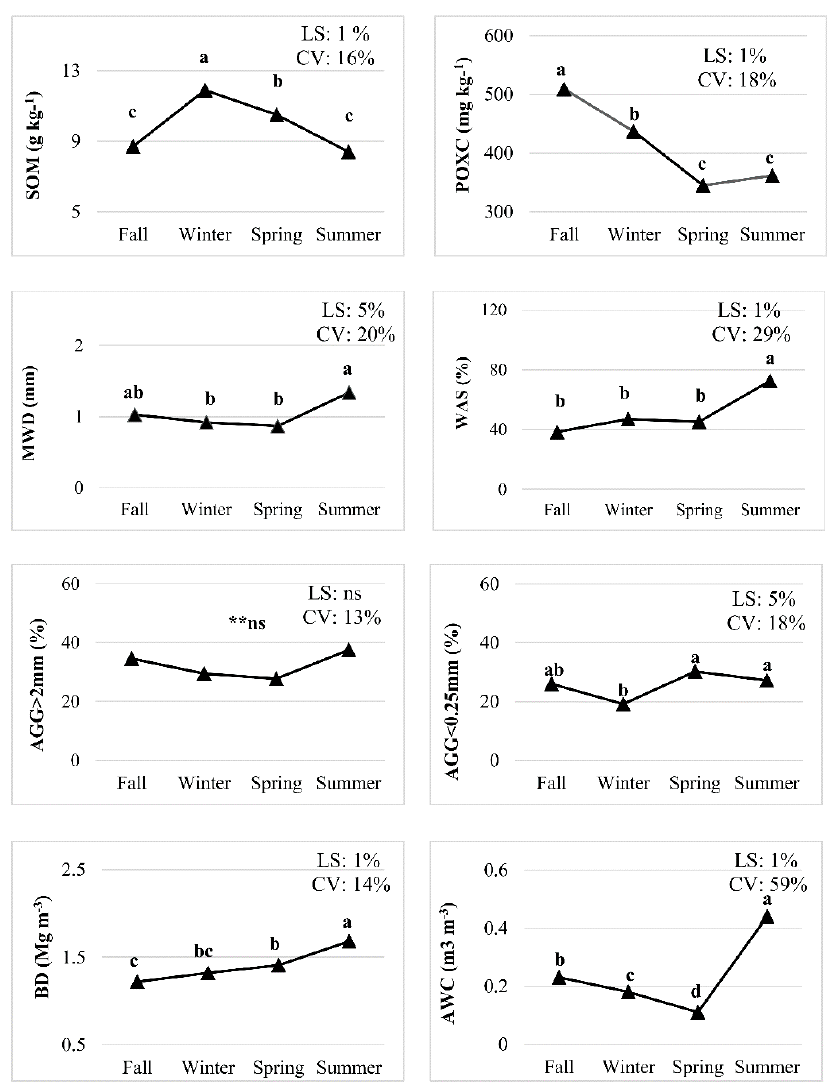
Figure 1. Variations of selected soil quality indicator measurements over four seasons. CV—coefficient of variability; LS—level of significance; BD—bulk density; AWC—available water capacity; AGG—aggregates. Means within the line with the same letter are not significantly different at p -value ≤ 0.05. Table 2. ANOVA results of treatment effects and their interaction for soil measurements.